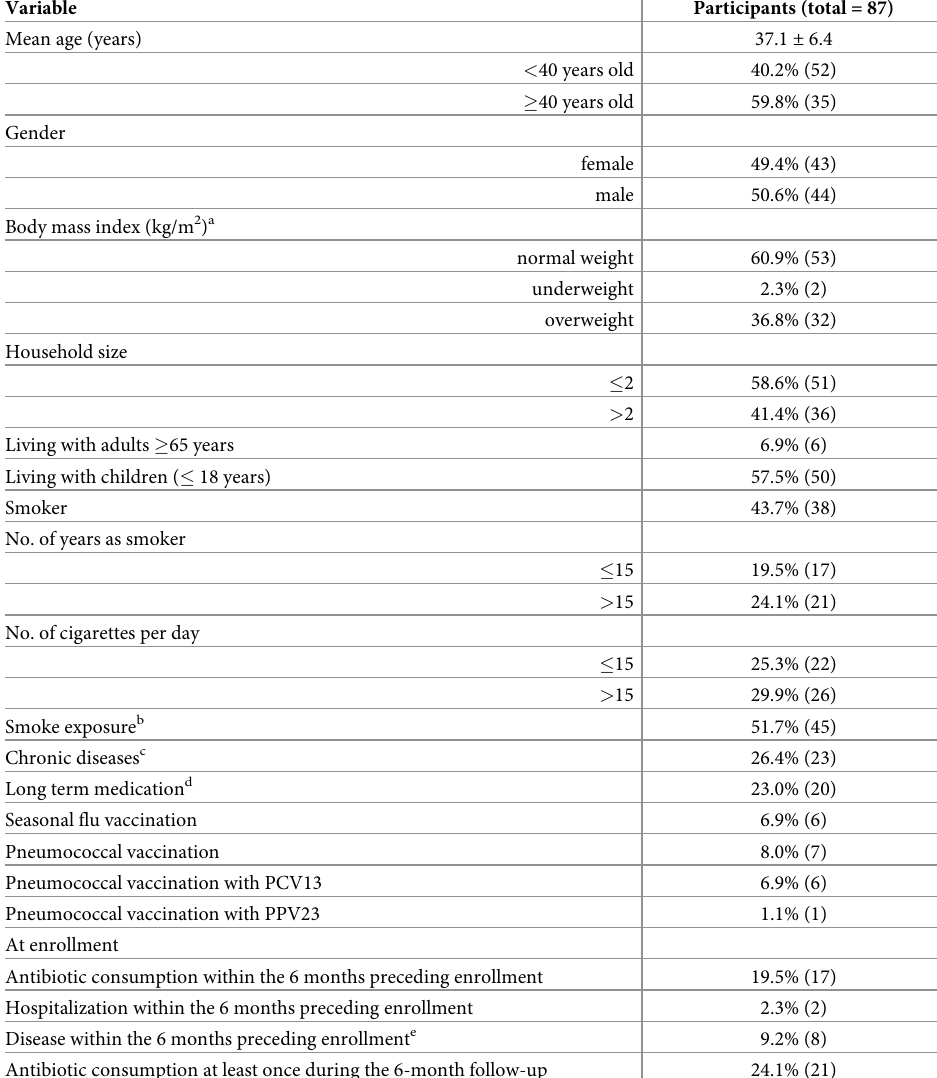
Table 1. Socio-demographic characteristics of the participants. Variable